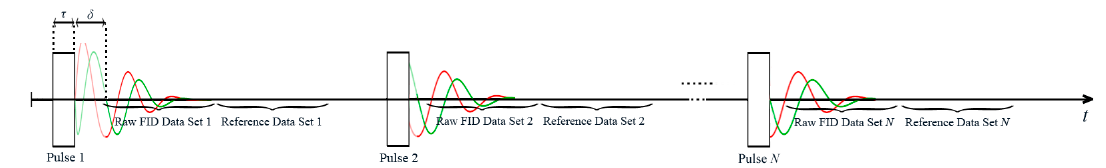
Figure 2. Sketch of the pulse sequence and the data selection.